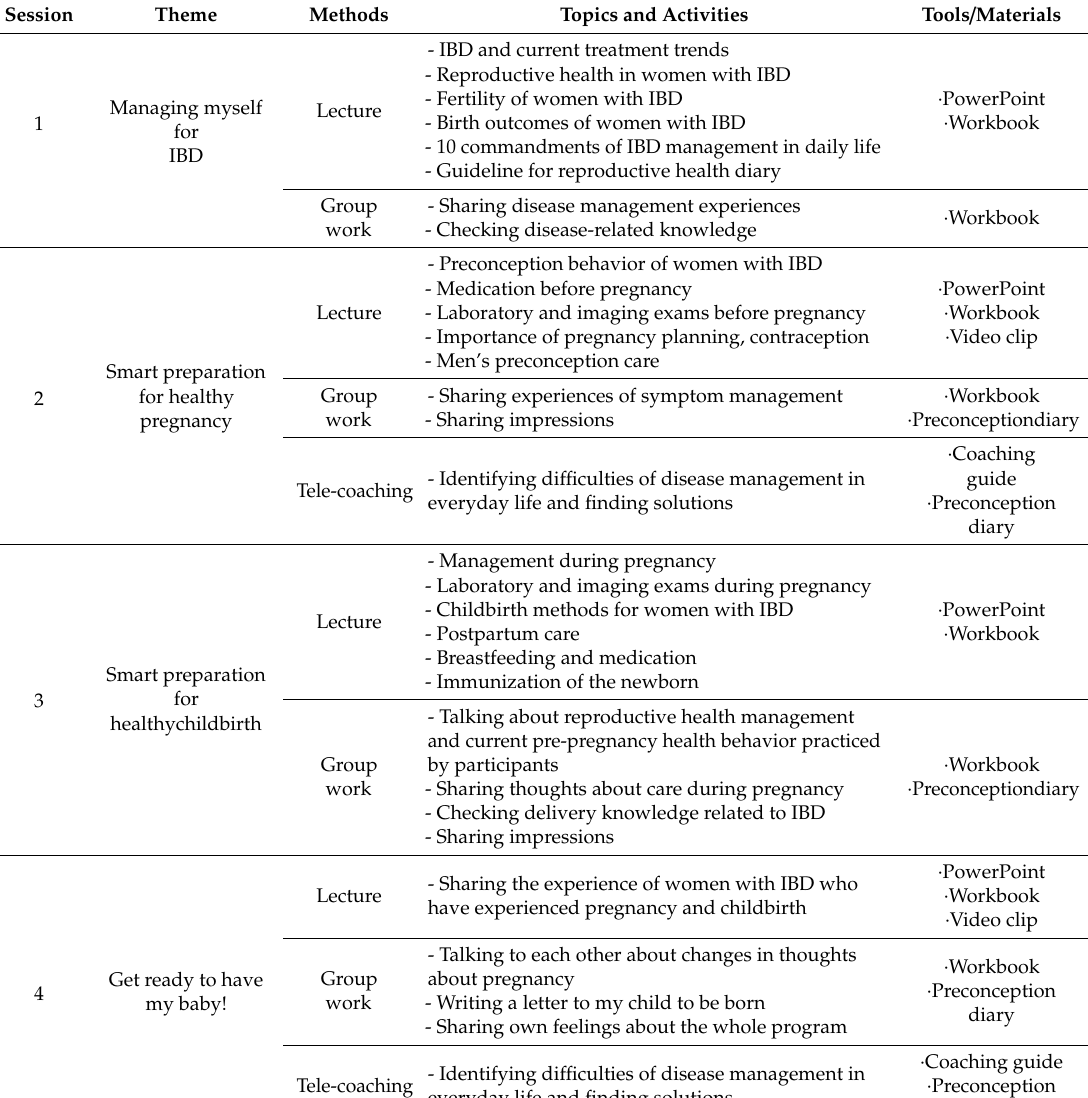
Table 4. Content of the preconception care program for women with